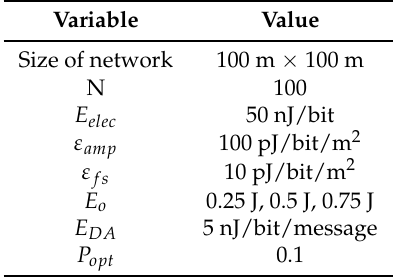
Table 1. Parameters and their values used in simulation